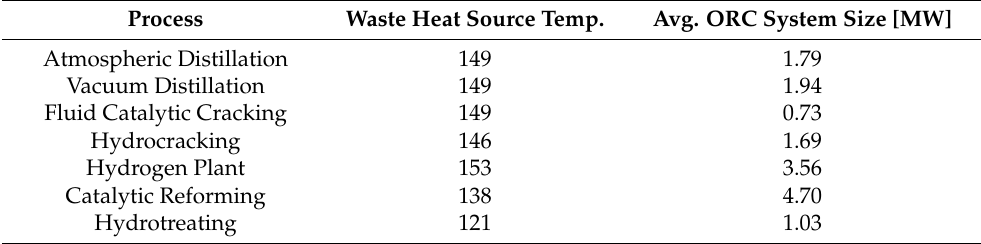
Table 1. Waste heat sources and average ORC system capacity in oil refining [17]. Process Waste Heat Source